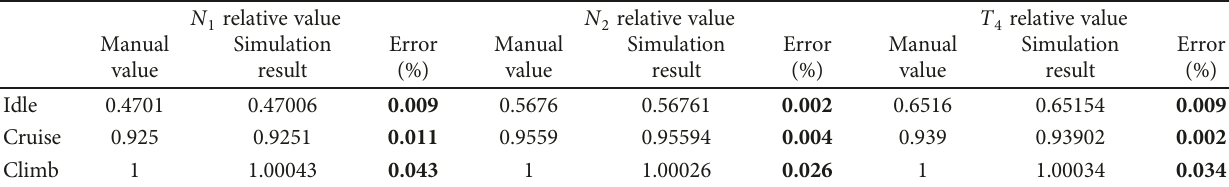
Figure 3: The results of the identi fi cation of mapping relation between the rotary. (a) The corresponding relation between the consumed work by fan and low rotor speed (spot-component test data, line-identi fi cation curve). (b) The corresponding relation between the produced work by LPT and low rotor speed (spot-component test data, line-identi fi cation curve). (c) The corresponding relation between the consumed work by HPC and high rotor speed (spot-component test data, line-identi fi cation curve). (d) The corresponding relation between the produced work by HPT and high rotor speed (spot-component test data, line-identi fi cation curve). Table 1: Steady simulation